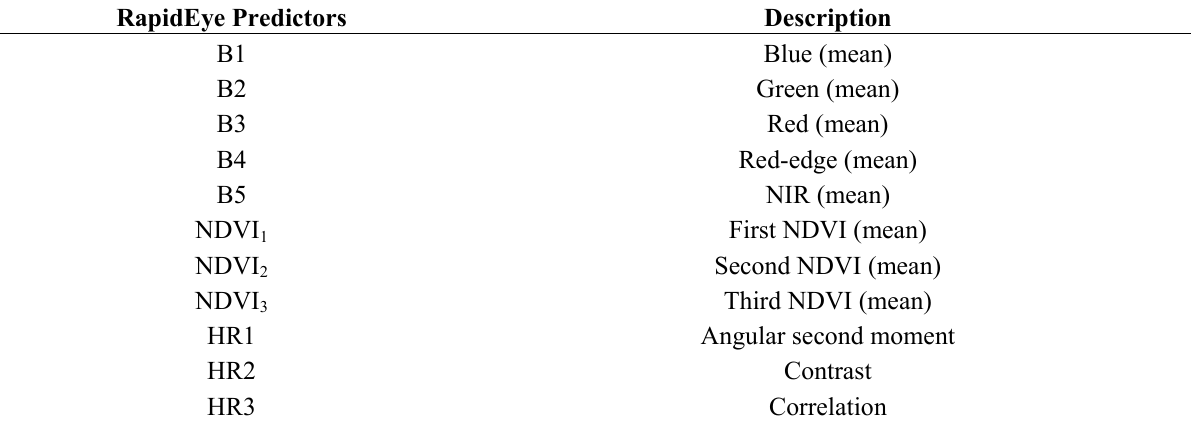
Table 4. List of RapidEye explanatory